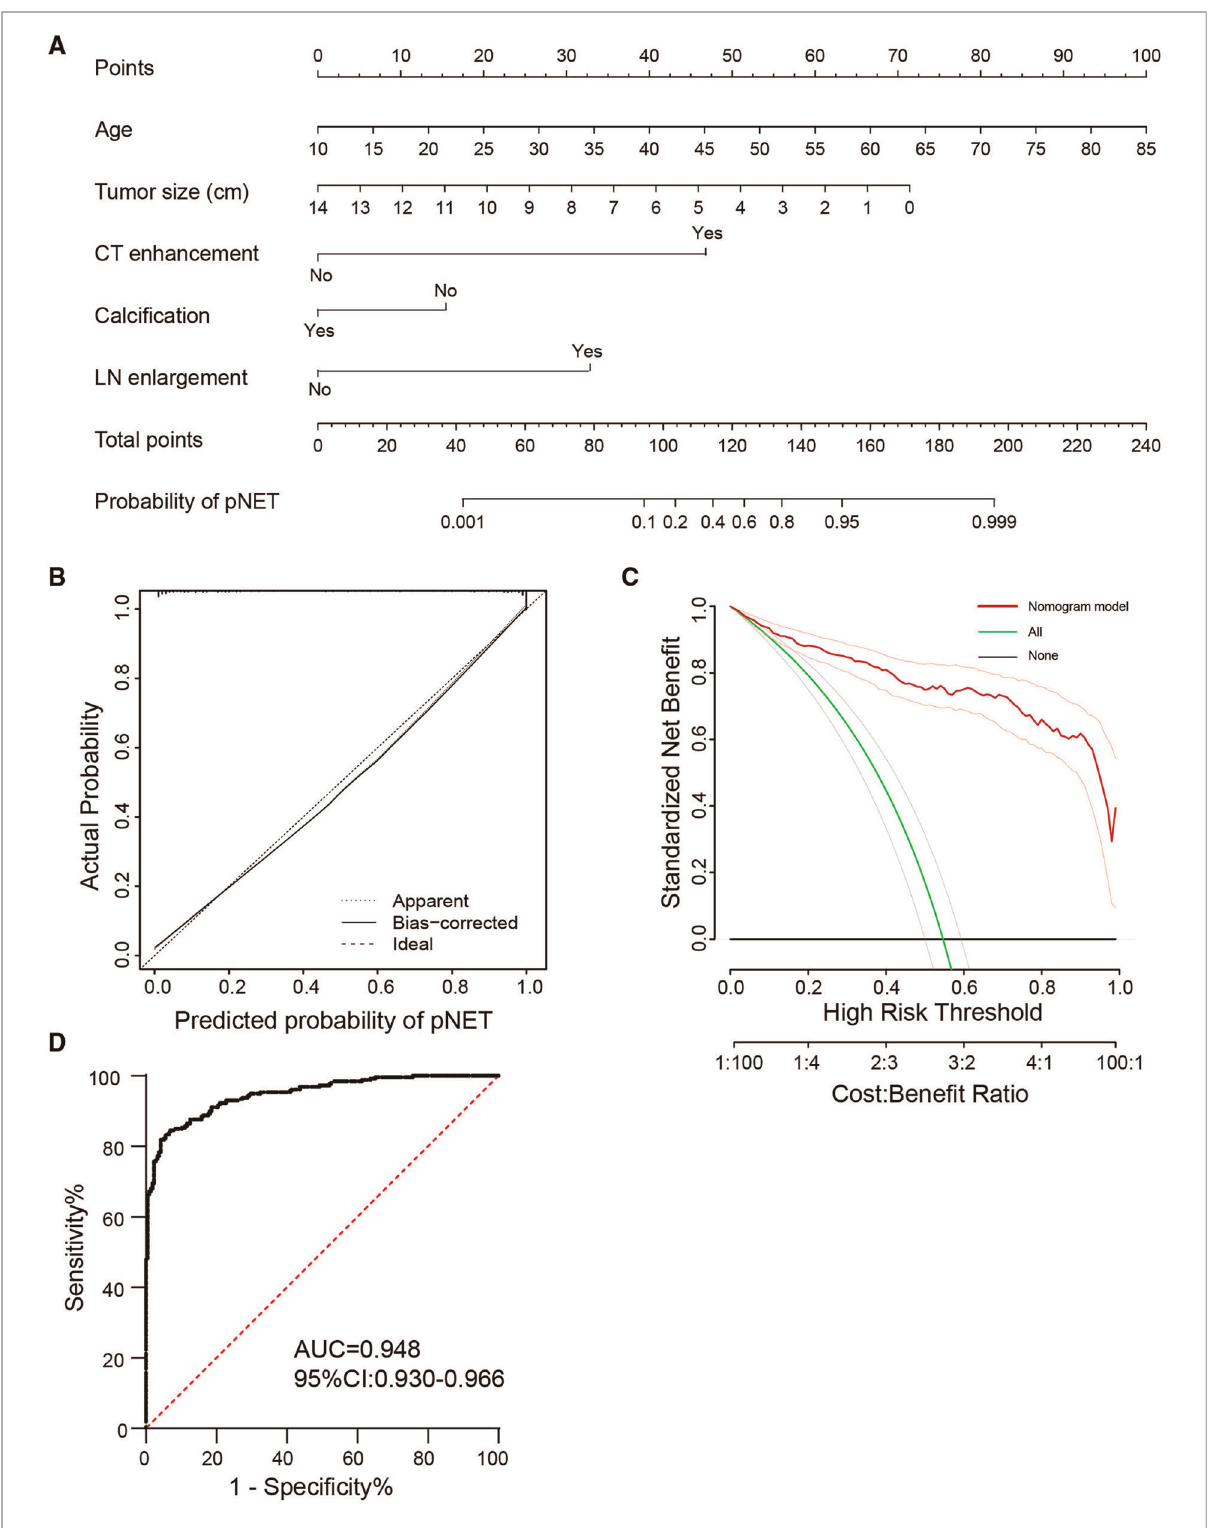
FIGURE 4 Nomogram and ROC curve of distinguishing pNET from SPT by fi ve clinicopathological features. ( A ) A nomogram incorporating the presence of age, tumor size, strong enhancement intensity, calci fi cation, and LN enlargement. ( B,C ) Calibration curve and decision curve analysis to distinguish two tumors using the nomogram ( A ). ( D ) ROC curve of the model in differentiating pNET and SPT. ROC, receiver operator curve; LN, lymph node; pNET, pancreatic neuroendocrine tumor; SPT, solid pseudopapillary